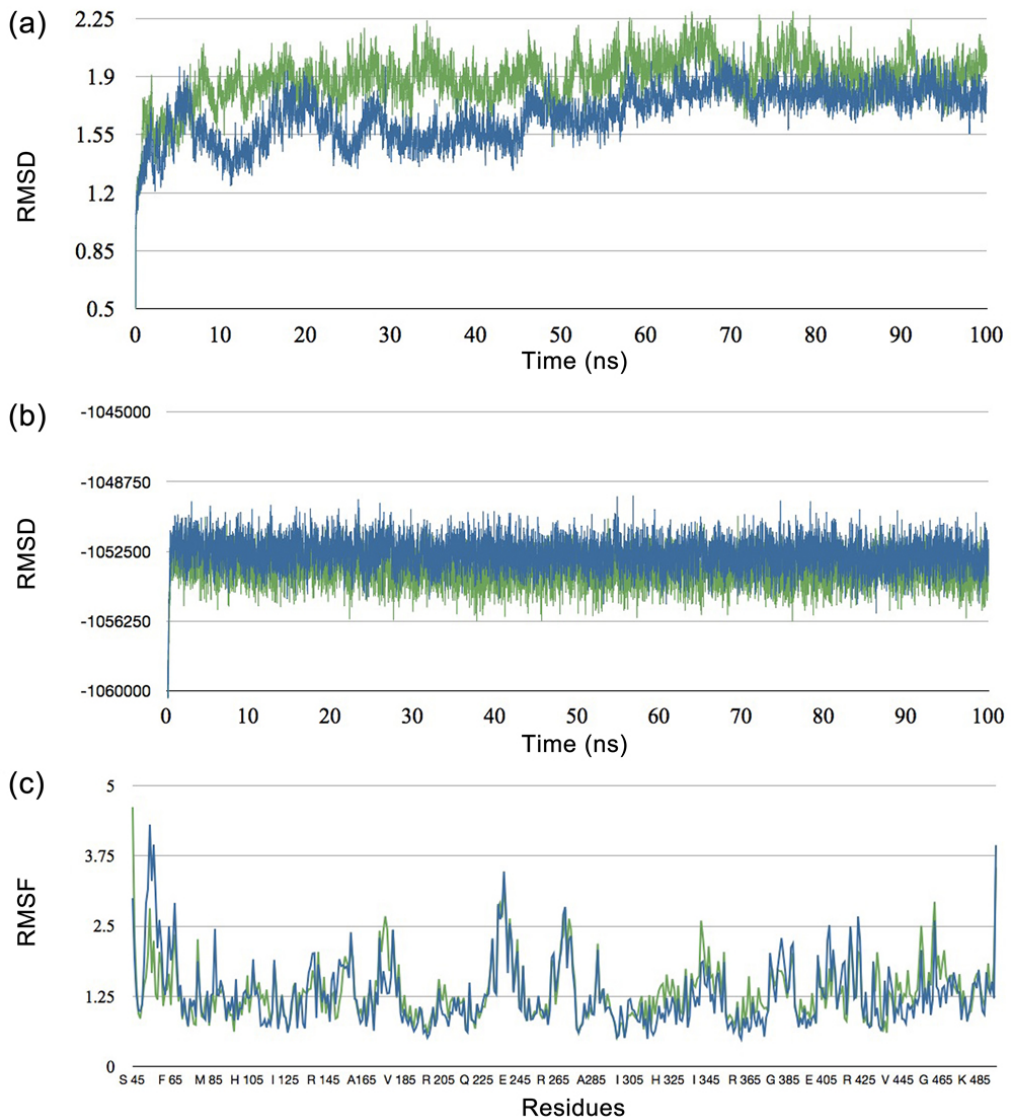
Figure 3. Result from molecular dynamics simulation showing the ( a ) RMSD, ( b ) Energy and ( c ) RMSF of aromatase in its bound (blue) and unbound (green)